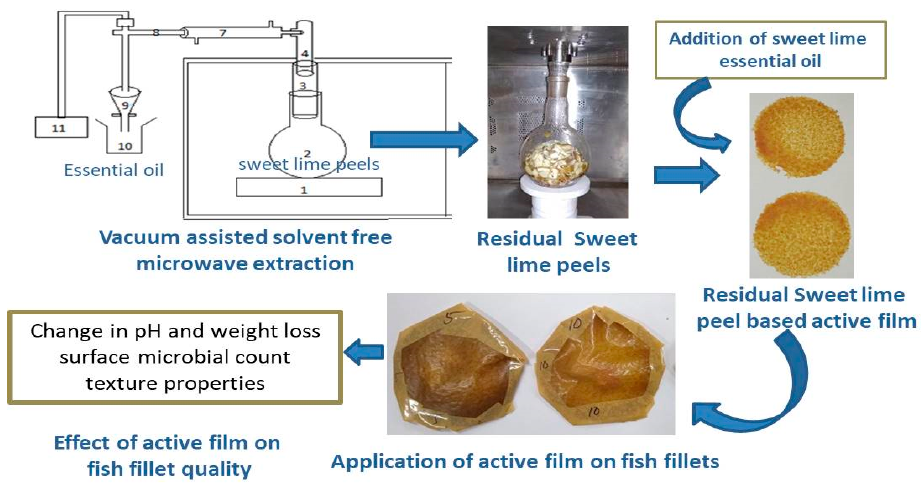
Figure 1. Development of sweet lime peel residue-based active film and its application on fish fillet.